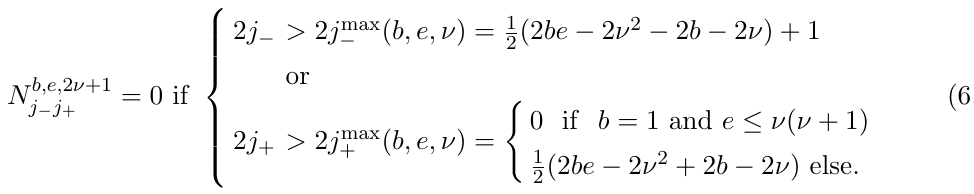
Table 7 . Asymptotics of refined BPS invariants of the massive M-string for µ even. whereas for odd